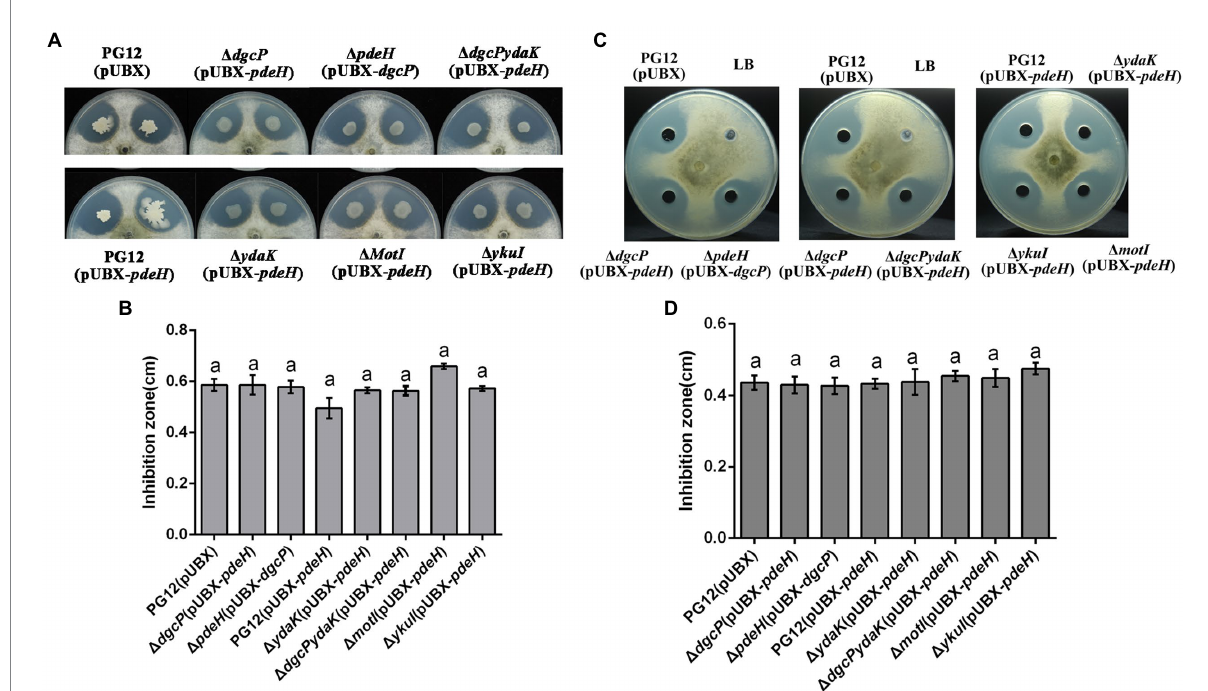
FIGURE 4 The antagonistic activity of B. velezensis PG12(pUBX) and its derivatives against apple ring rot disease. The antifungal activity of bacterial cultures (A,B) or cell-free supernatants (C,D) against B. dothidea was explored using the dual culture assay in PDA plates supplemented 1% xylose solution at the final concentration. 1- μ l bacterial cultures or 200 μ l cell-free supernatants of B. velezensis PG12(pUBX) [PG12(pUBX)], PG12(pUBX- pdeH ) [PG12(pUBX- pdeH )], Δ dgcP (pUBX- pdeH ), Δ pdeH (pUBX- dgcP ), Δ ydaK (pUBX- pdeH ), Δ motI (pUBX- pdeH ), Δ ykuI (pUBX- pdeH ), or Δ dgcPydaK (pUBX- pdeH ) were equidistantly spotted around the fungal inoculums. LB broth (LB) was used as control. Images were taken (A,C) and the diameter of disease lesions (B,D) was measured 7 days post inoculation. Values correspond to the mean inhibition zone of three replicates. The data is a representative of three independent experiments. Different letters on the column indicate significant differences between different treatments according to the least significant difference (LSD) test ( p <